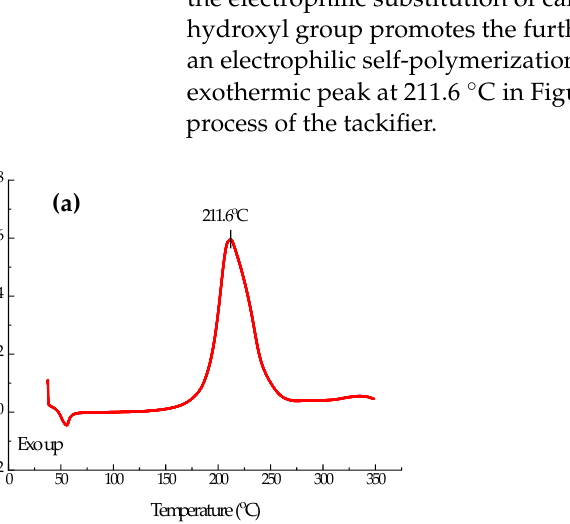
Figure 1. Images of carbon fiber fabric surfaces with benzoxazine-based tackifier BT5501A, ( a ) be- fore baking and ( b ) after baking.